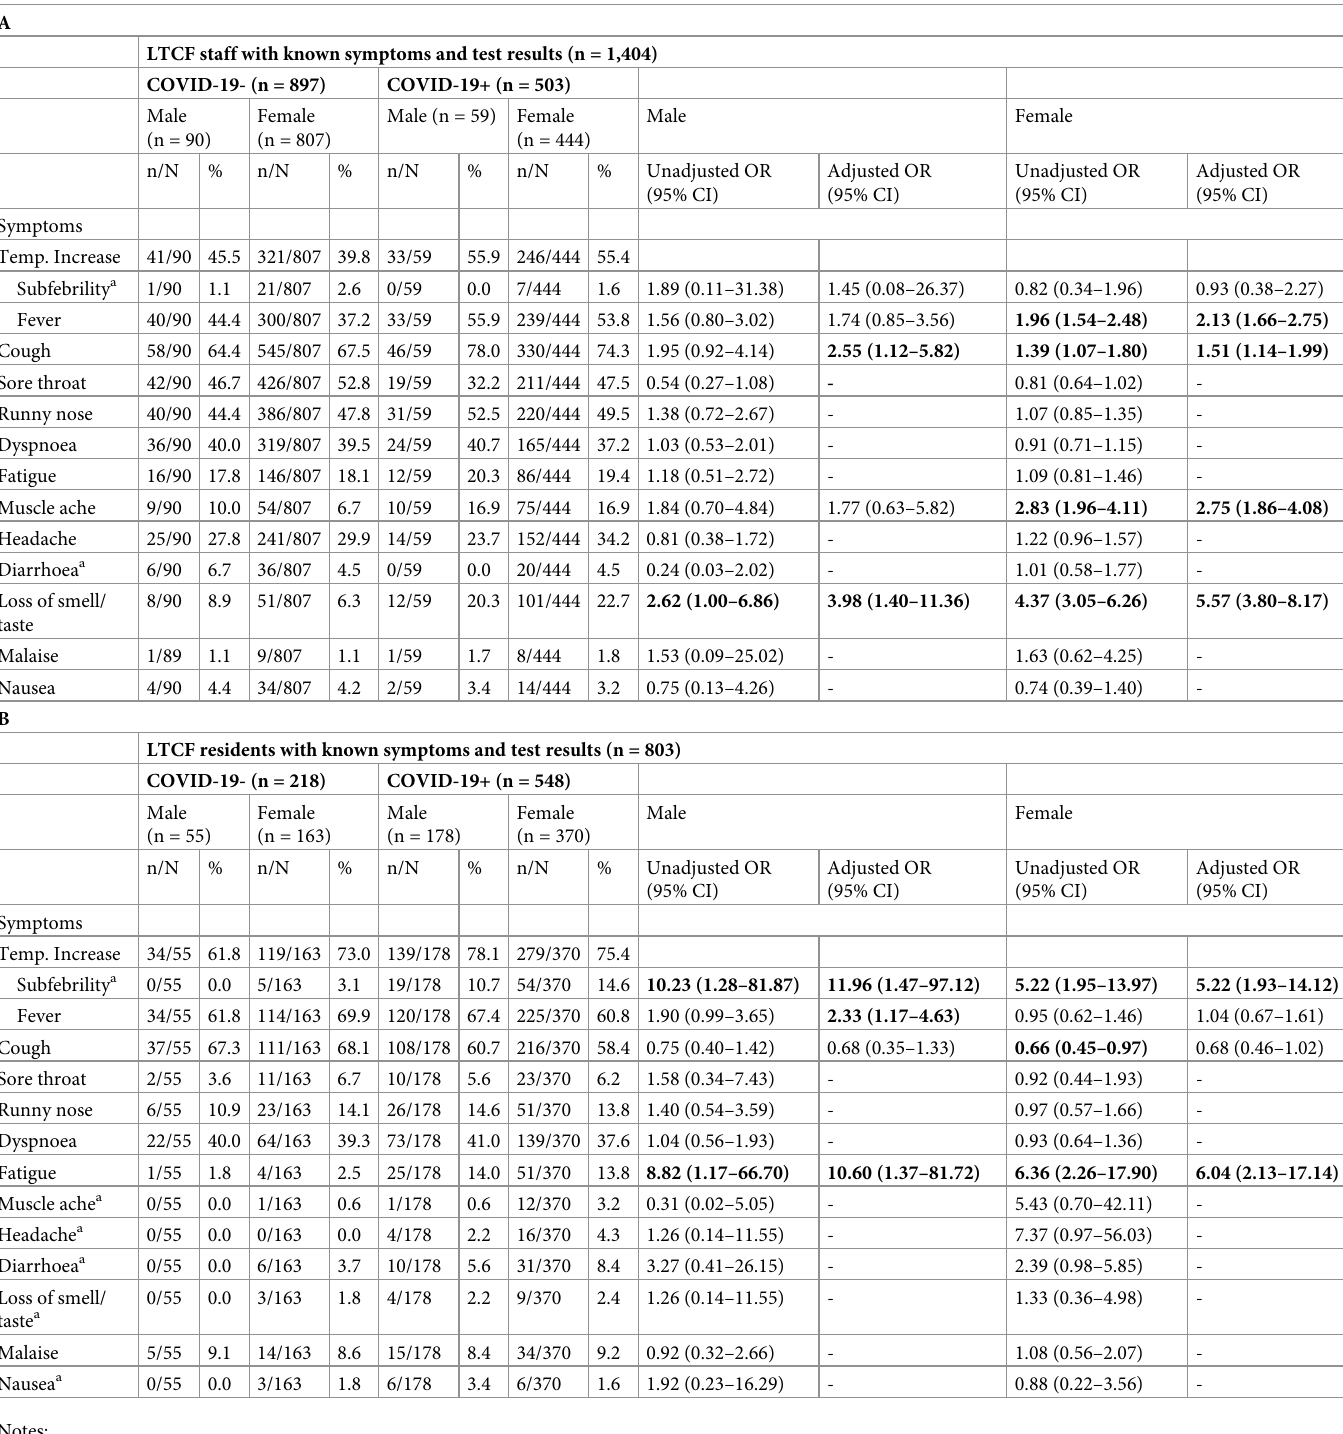
Significant odds ratios are displayed in bold ( α � 0.05). Table B: a) Because there was no case for subfebrility, muscle ache, headache, diarrhoea, loss of smell/taste, and nausea, a COVID-19+ case was